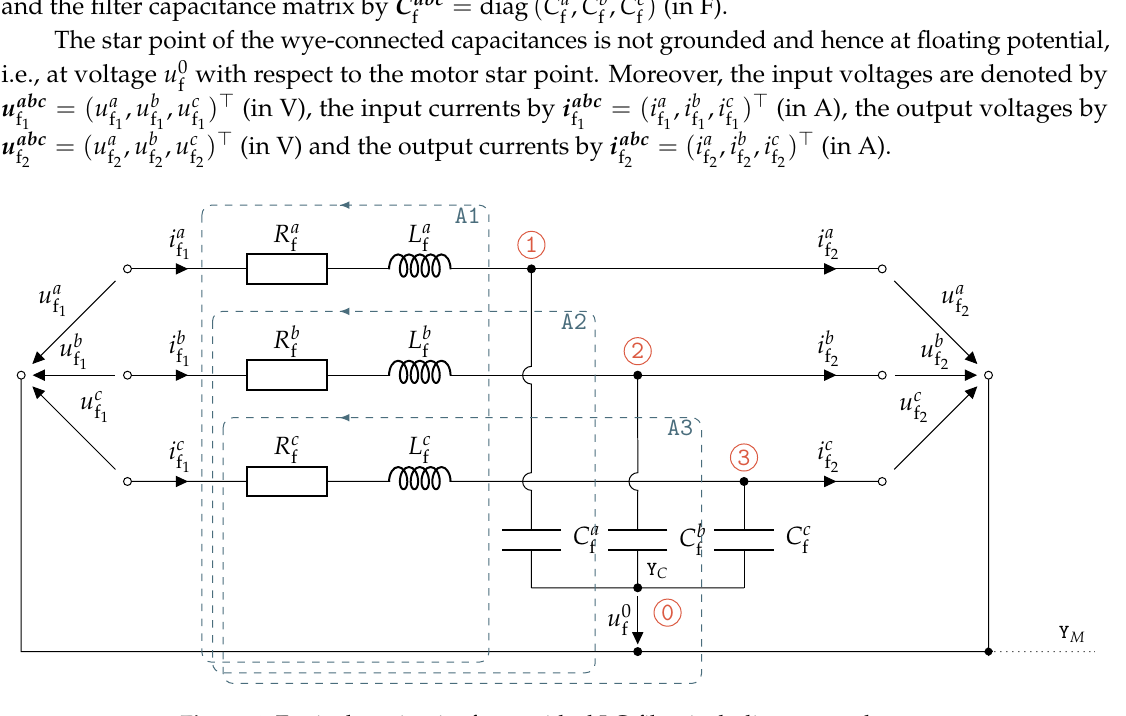
Figure 4. Equivalent circuit of a non-ideal LC-filter including copper